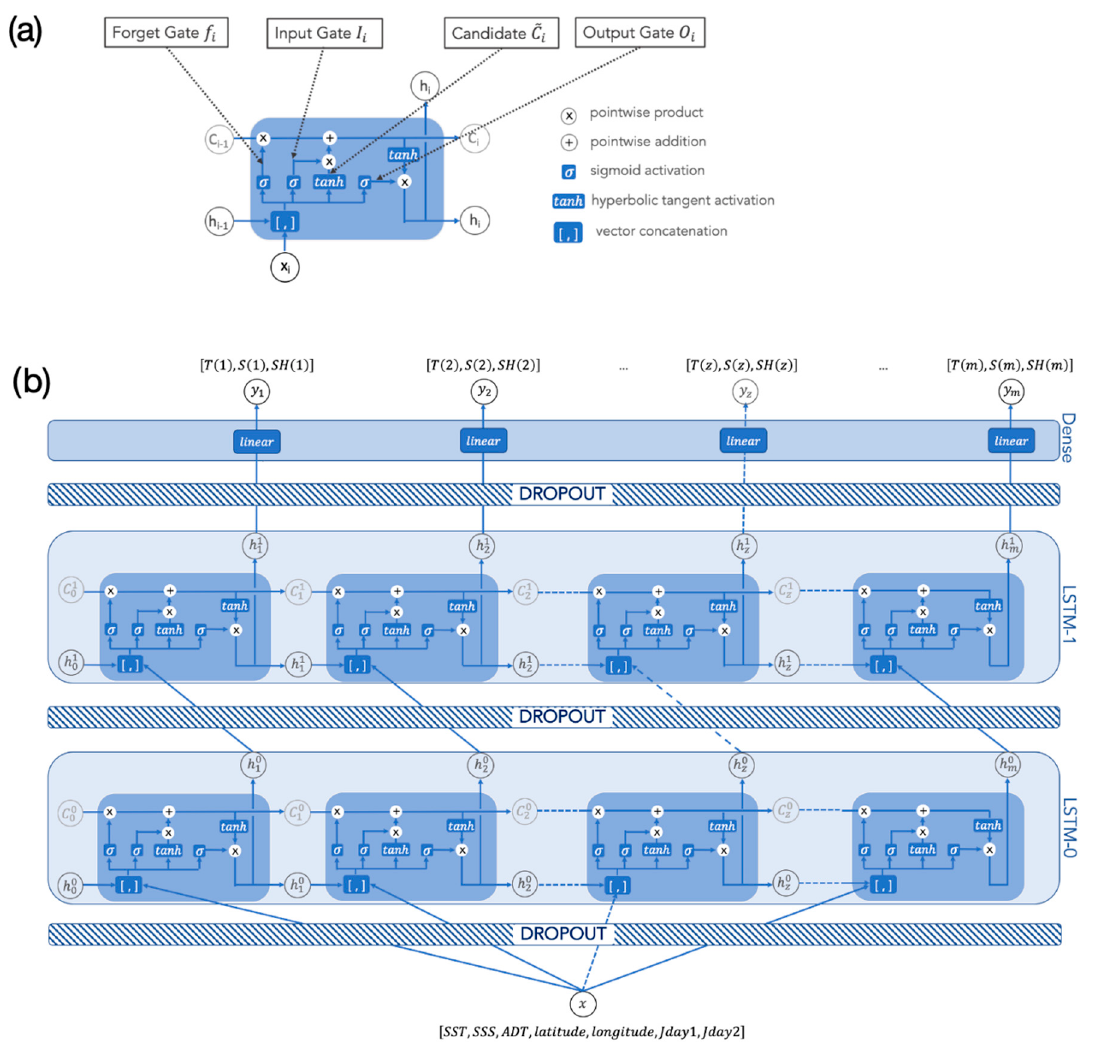
Figure 2. Diagram showing the elements of a single LSTM cell ( a ). Stacked LSTM model for the reconstruction of vertical hydrographic profiles ( b ).